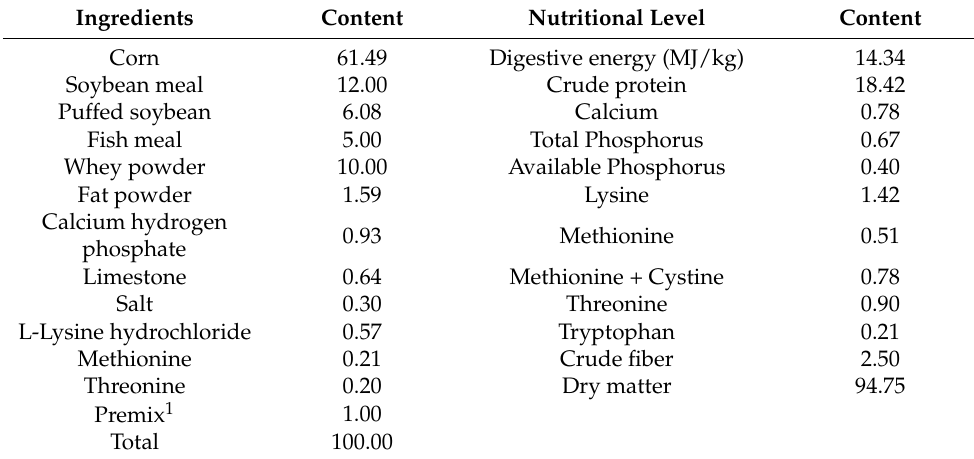
Table 1. Diet composition and nutritional level (air-dried